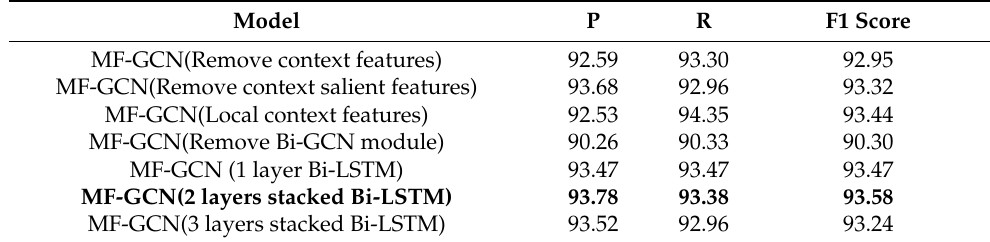
Table 3. Ablation experiment of MF-GCN in mechanical fault detection dataset (unit:%). Model P R F1 Score MF-GCN(Remove context